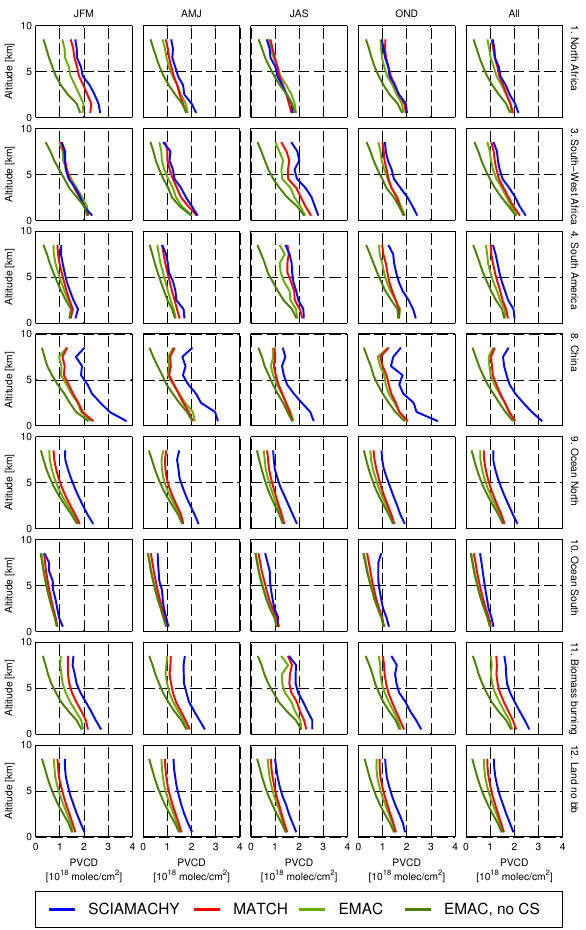
) for all regions Fig. 10. Relative differences ( model − SCIAMACHY SCIAMACHY shown in Fig.